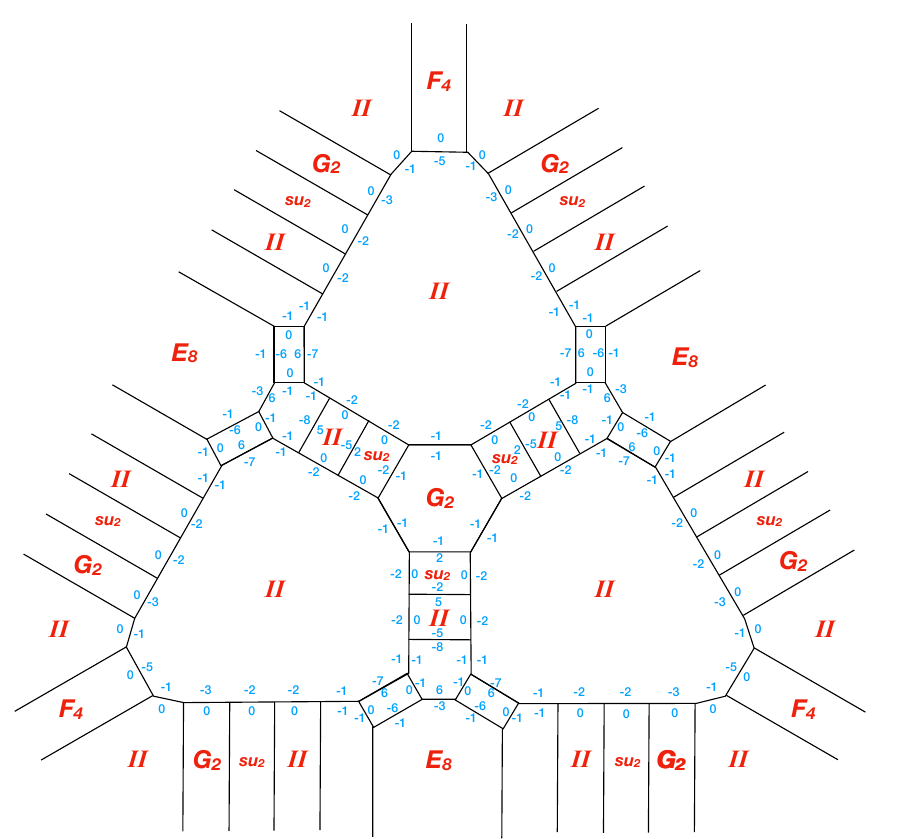
Figure 8 . The completely blown up E 8 { E 8 { E 8 Yukawa